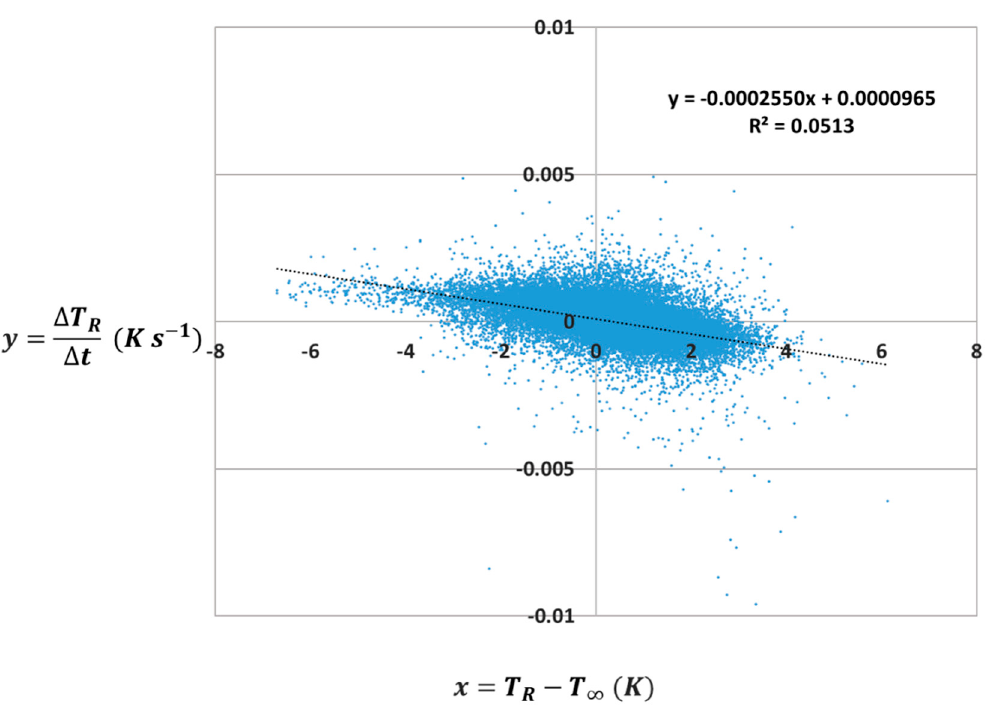
Figure 8. Linear correlation of change in temperature inside the PBR over time vs. temperature inside the PBR minus ambient temperature. Data were acquired during the 2015 East Bend growing season. Graph represents over 42,000 data points averaged every five minutes over a 5 month period.